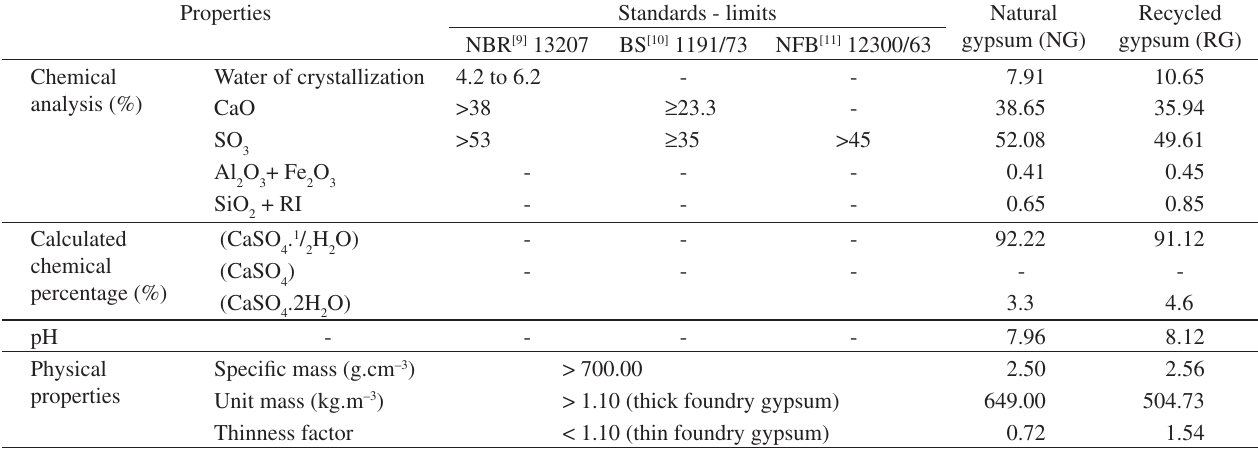
Table 1. Chemical and physical characteristics of the natural (NG) and recycled (RG) gypsum.